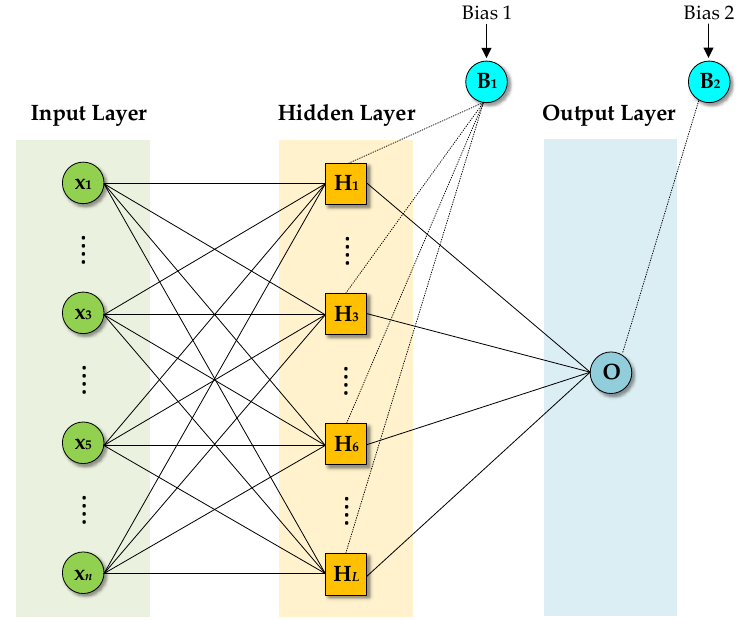
Figure 2. General structure of multilayer perceptron (MLP)-type artificial neural network (ANN).